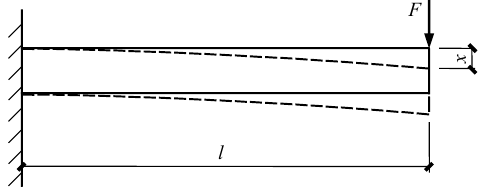
Figure 9. Schematic diagram of a cantilever beam.